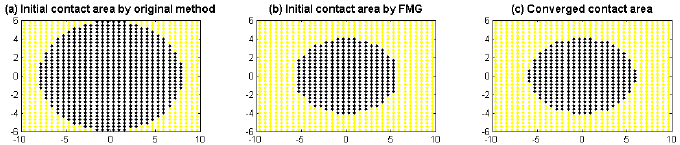
Figure 8. Hertzian contact: contact areas on a 32 × 32 grid: (a) the initial contact area obtained by the original method, selecting all the elements I with h I ≤ 0, (b) the initial contact area by the FMG scheme, (c) the converged contact